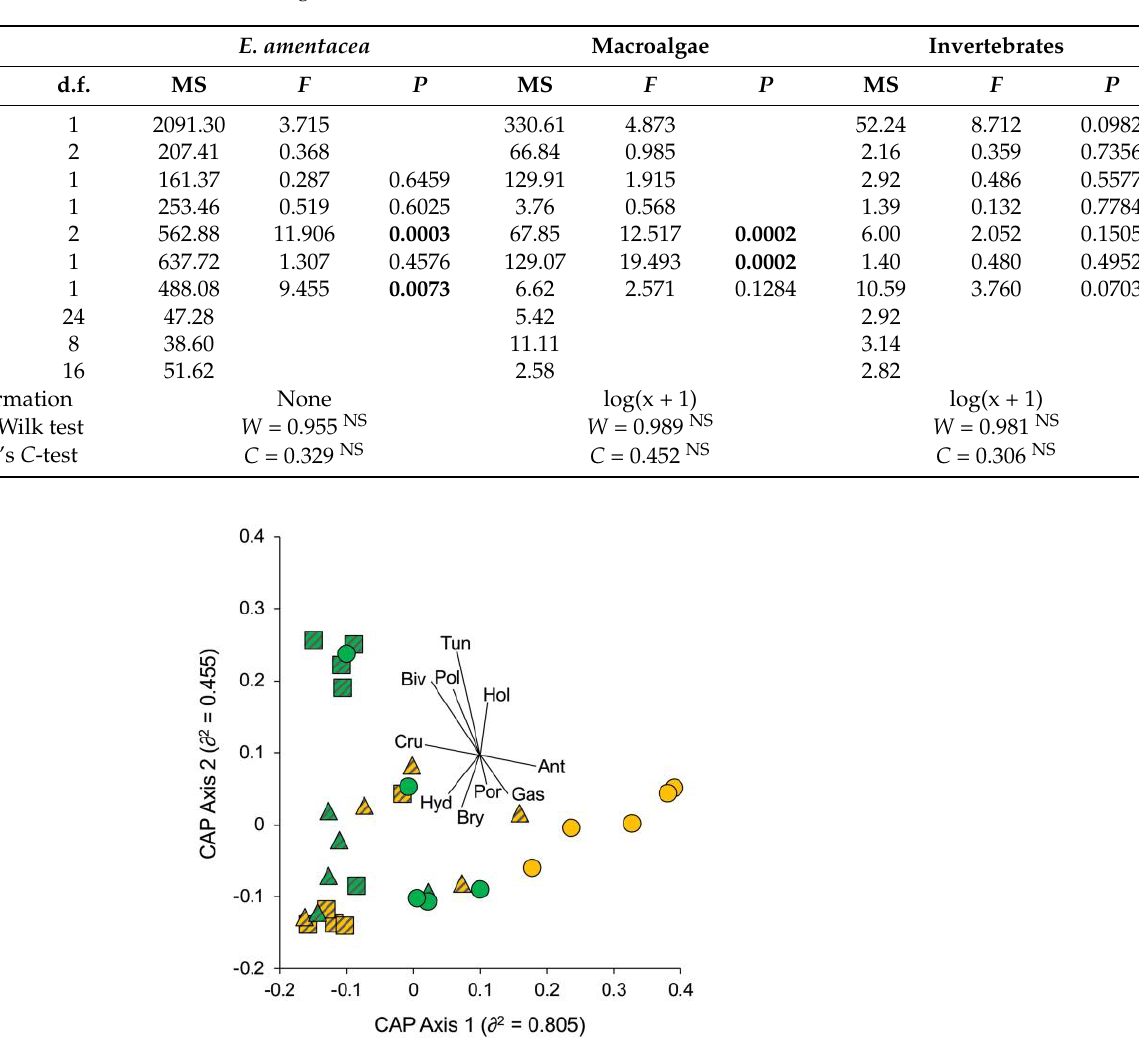
Table 2. Summary of asymmetrical ANOVA testing for differences between P and Cs in total biomass (dry weight) of E. amentacea , associated macroalgae, and invertebrates at CIC. The main effect of terms involved in higher-order interactions were not tested. Results of tests for the assumption of normality (Shapiro–Wilk test) and variance heterogeneity (Cochran’s C -test) were also reported: NS = not significant.